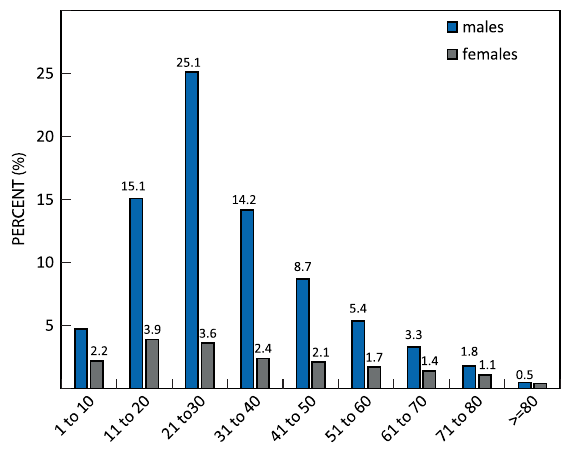
Figure 5: Percentages of non-natural deaths among different age groups in the Transkei region of South Africa ( n = 24 253).